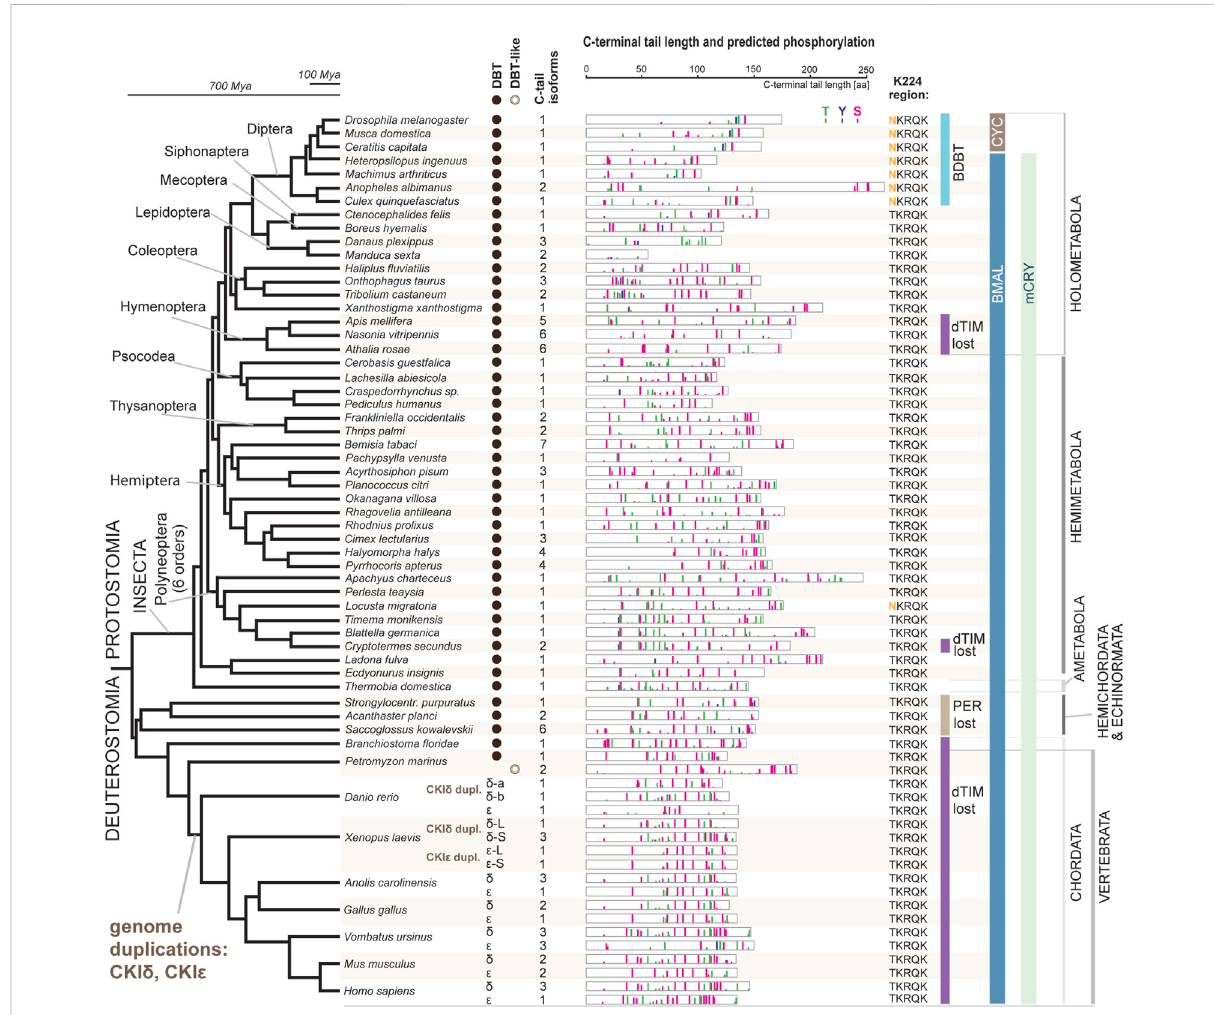
FIGURE 3 DBT and CKI δ / ε genes and proteins mapped on insect and deuterostomian phylogeny. The phylogenetic tree corresponds to a consensus of recentphylogenomicstudies(Misofetal.,2014;Johnsonetal.,2018;Kawaharaetal.,2019;McKennaetal.,2019;Wip fl eretal.,2019).Representative species are shown at the terminal nodes. The fi rst column indicates the presence of DBT-coding genes (note a Petromyzon -speci fi c gene duplication). Greek letters refer to the presence of CKI δ and CKI ε ; note two CKI δ paralogs in Danio and Xenopus and two CKI ε paralogs in Xenopus (for details on CKI δ and CKI ε phylogeny, see Figure 4). The second column indicates how many splicing isoforms affecting the C-terminal tailproteinsequencewereidenti fi ed.TheC-terminaltailofthelongestisoformisdepictedforeachgeneineachspecies(seeSupplementaryFigures S2 – S7forall isoforms andadditional species).The colorbarsindicate insilico predictedphosphorylation patterns ofthreonine(T,green), tyrosine (Y, blue), and serine residues (S, pink). The bar ’ s height refers to the predicted score between 0.5 – 1.0. K224 region indicates whether NKRQK or TKRQK motif was found in the region corresponding to the 220 – 224 position within the catalytic domain of D. melanogaster DBT. Major changes in the circadian clock setup are depicted: presence of CRY mammalian (mCRY) type, loss of TIMELESS-drosophila type (dTIM), loss of PERIOD (PER) (Kotwica-Rolinska et al., 2022b), and transition of BMAL (activation domain is present) to CYC (activation domain lost) (Supplementary Figure S8). DBT-interacting protein paralogs BRIDE of DBT (BDBT) was found only in Diptera (for details and BDBT phylogeny see Figure